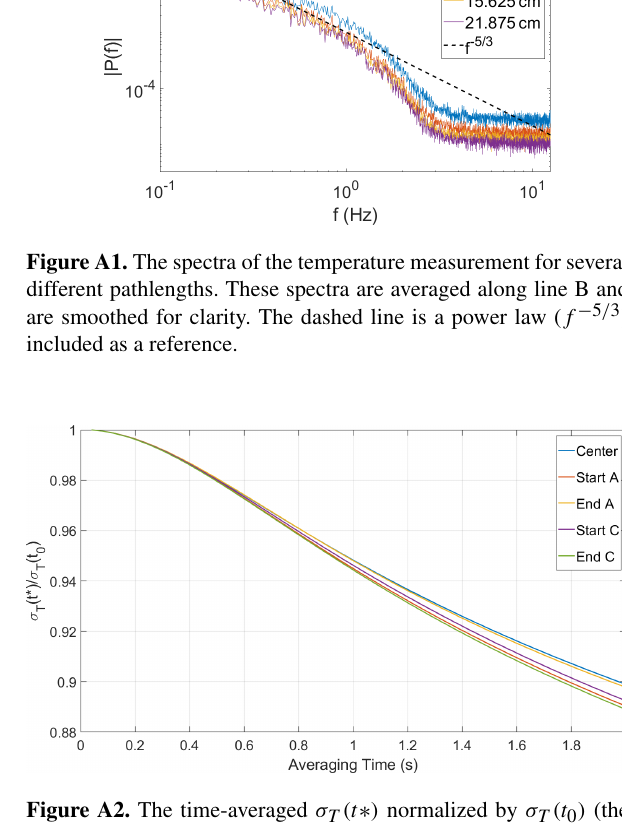
Figure A2. The time-averaged σ T (t ∗ ) normalized by σ T (t 0 ) (the standard deviation of the raw temperature time series). Over the time averaging of the sonic temperature sensor, σ T decreases to ≈ 94% σ T (t 0 ) .